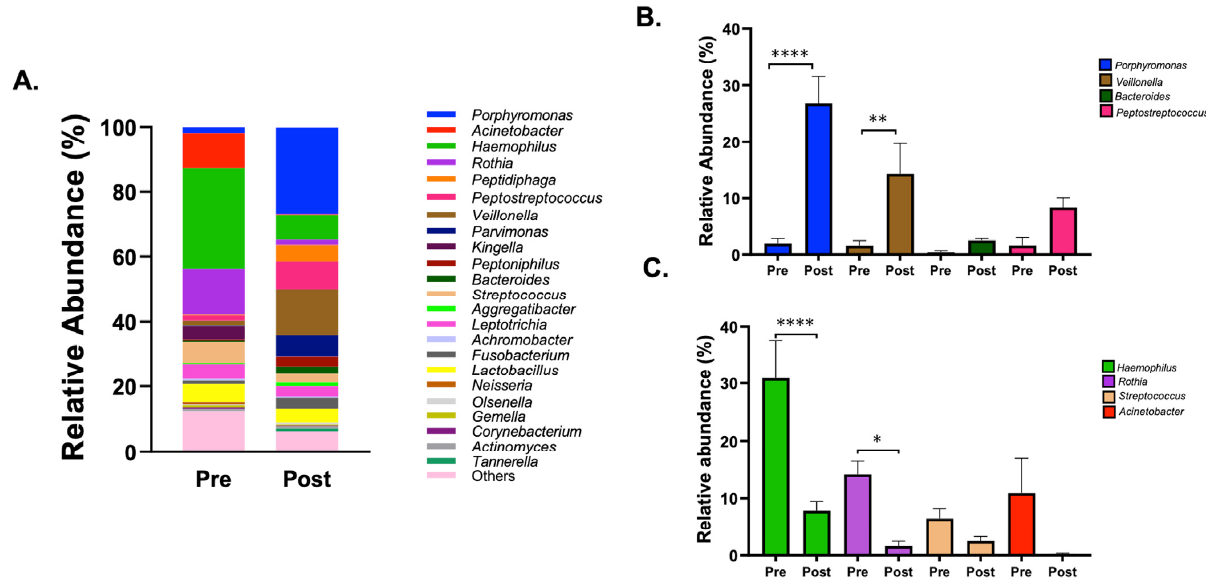
Figure 8. Microbial composition: Genus level microbial composition of the rats’ oral cavity as revealed by 16S rRNA gene sequencing. ( A ) The bar plots represent the relative abundance of genera present in the oral cavity of rats before (Pre) and 4-week after (Post) cementing the acrylic device with C. albicans . ( B ) Bar plots representing some of the genera that increased in the relative abundance post cementing the device with C. albicans ( C ) Bar plots representing some of the genera that showed decreased relative abundance post cementing the device with C. albicans . **** indicates p < 0.0001, ** indicates p < 0.01 and * indicates significant differences of p < 0.05.